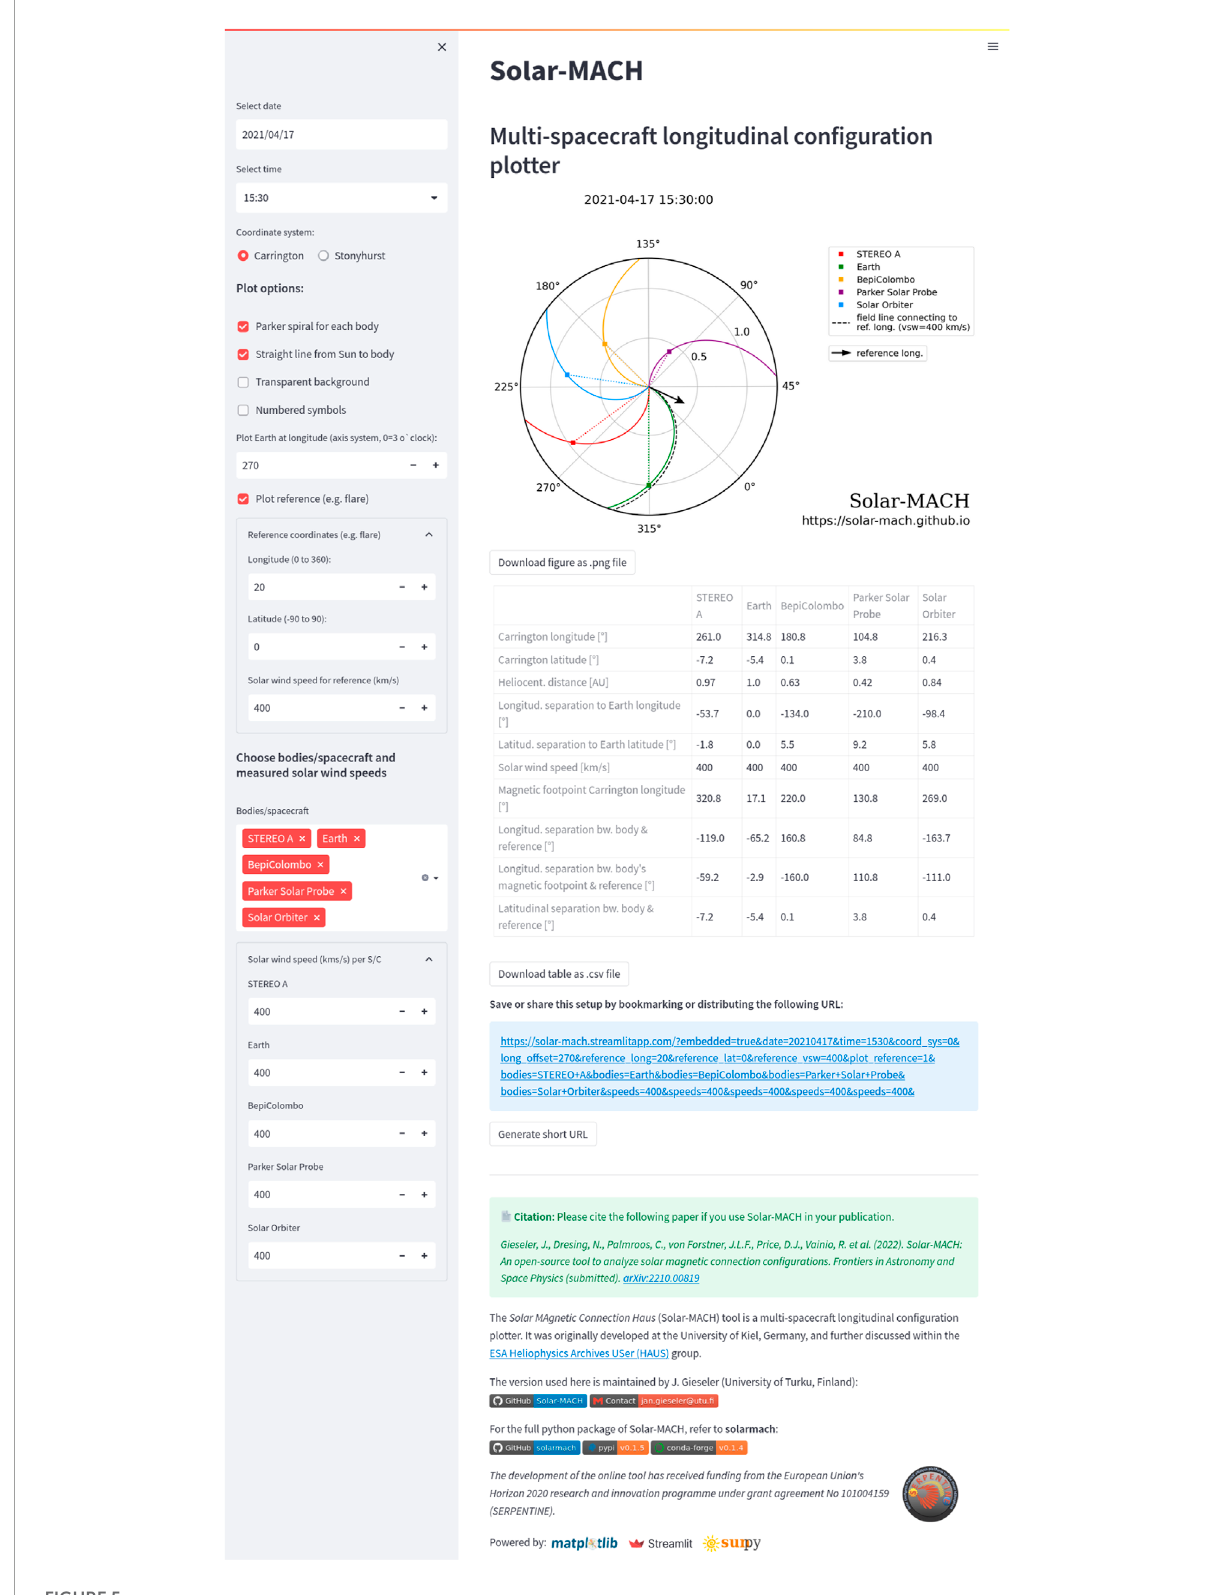
FIGURE 5 The Streamlit web version at